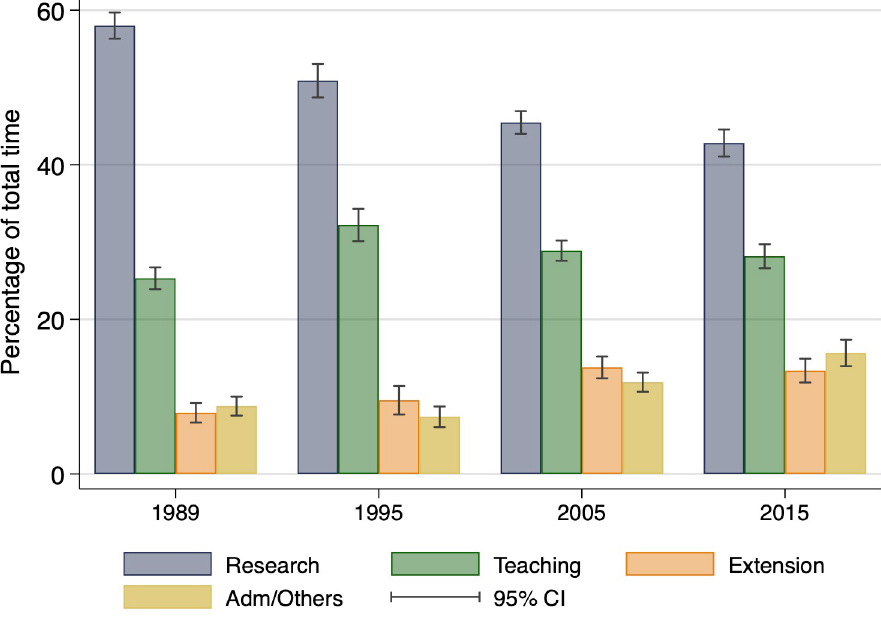
Fig 10. Allocation of faculty research time by type of activity. This figure displays the percent of time actually allocated to each group of activities. This might differ from percentages defined in their formal appointments. N =